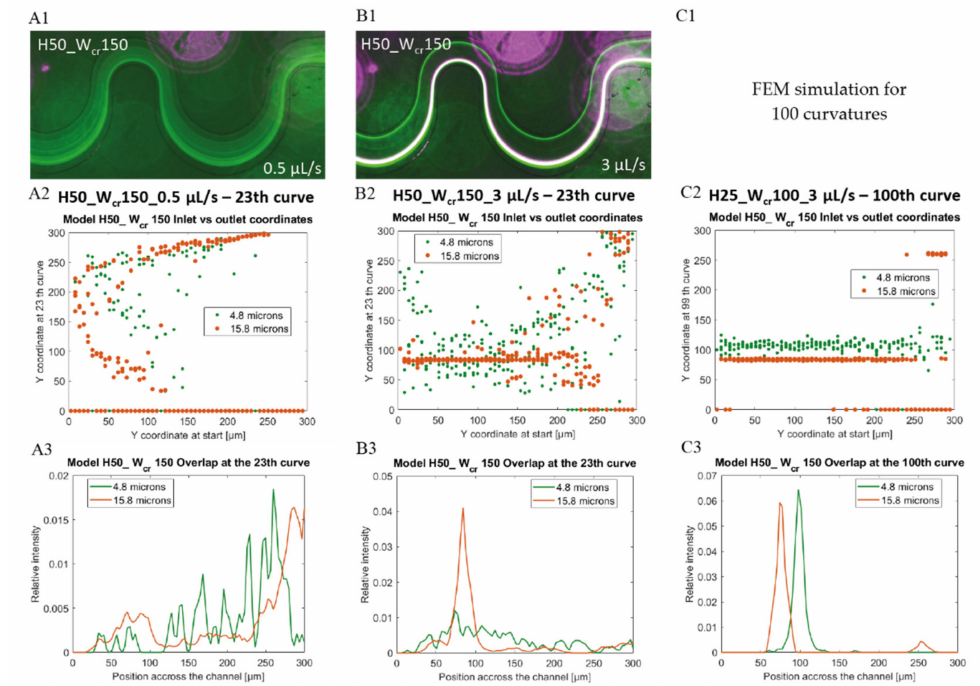
Figure 7. Lateral positions of 4.8 µ m (green) and 15.8 µ m (purple or orange) beads in microfluidic channel H50_W cr 150 after 23 curves at flow rates 0.5 µ L/s ( A1 – A3 ) and 3 µ L/s ( B1 – B3 ). Experimental ( A1 , B1 fluorescent images) and computational data of beads’ focusing tendency through the channel as y coordinates at the outlet vs. initial y coordinates ( A2 , B2 , C2 ) and calculated lateral distribution at the end of the channel ( A3 , B3 , C3 ). ( C1 ) FEM simulation for 100 curvatures, ( C2 , C3 ) represents the modelled result after 100 curves in case of at 3 µ L/s flow